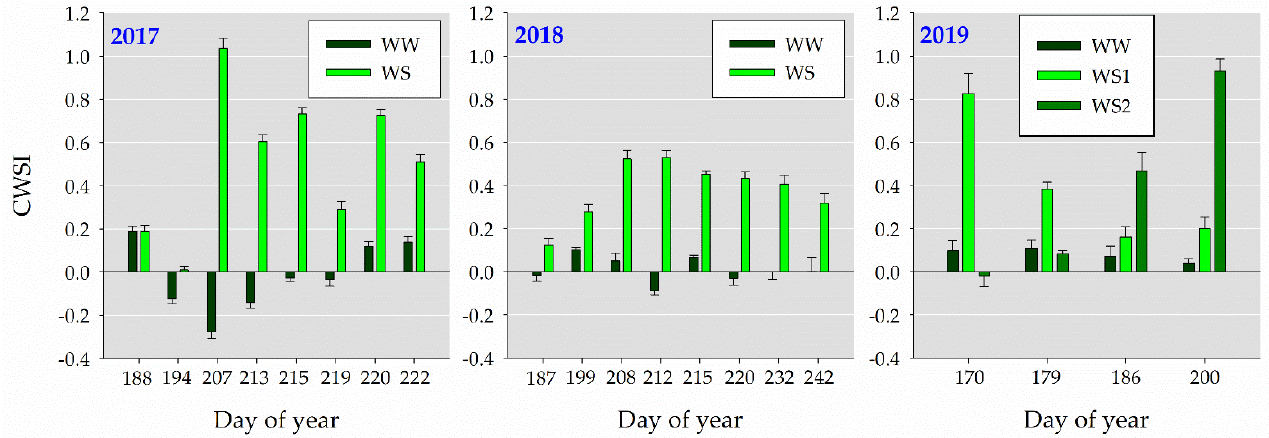
Figure 7. Mean crop water stress index (CWSI) determined throughout the experimental periods of 2017, 2018, and 2019 in well-watered (WW) and water-stressed (WS) maize plots. In 2019, WS1 and WS2 stand for flowering and grain-filling water stress, respectively. Each bar indicates the mean ± s.e. of 18 (2017, 2018) and 12 (2019) maize breeding plots.